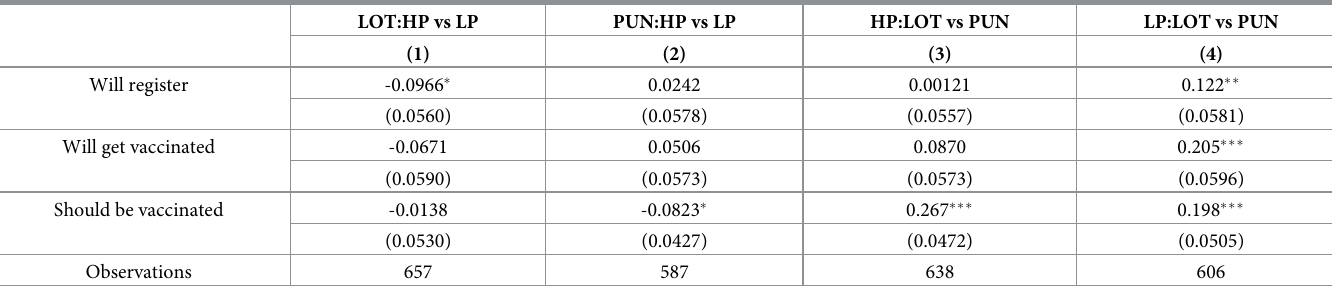
Table 7. Effect of incentives and expectations on hypothetical vaccination